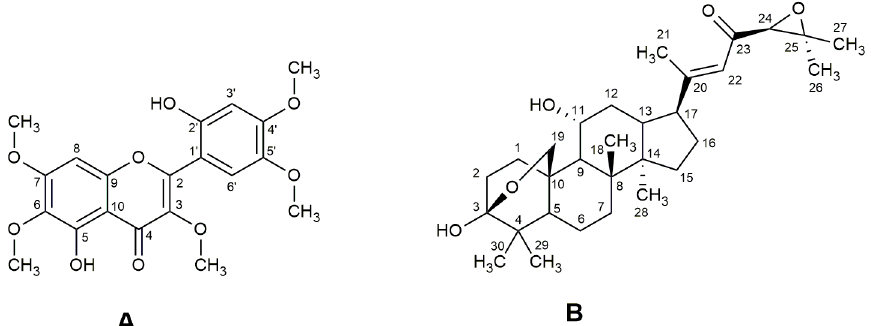
Figure 1. Chemical structures of brickellin ( A ) and cordialin A ( B ).